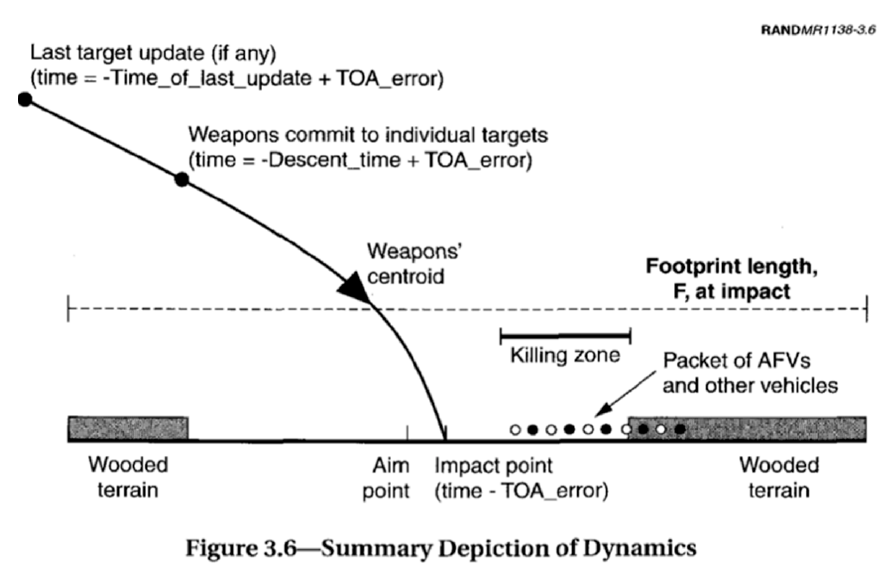
Figure 4. A simple but high-resolution physics model.